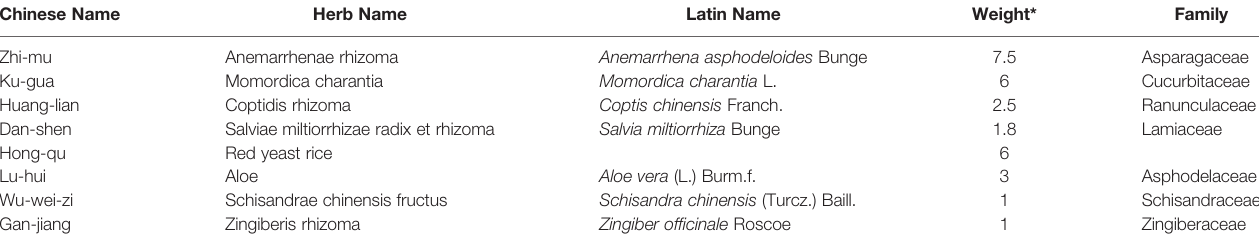
TABLE 1 | The compostion of